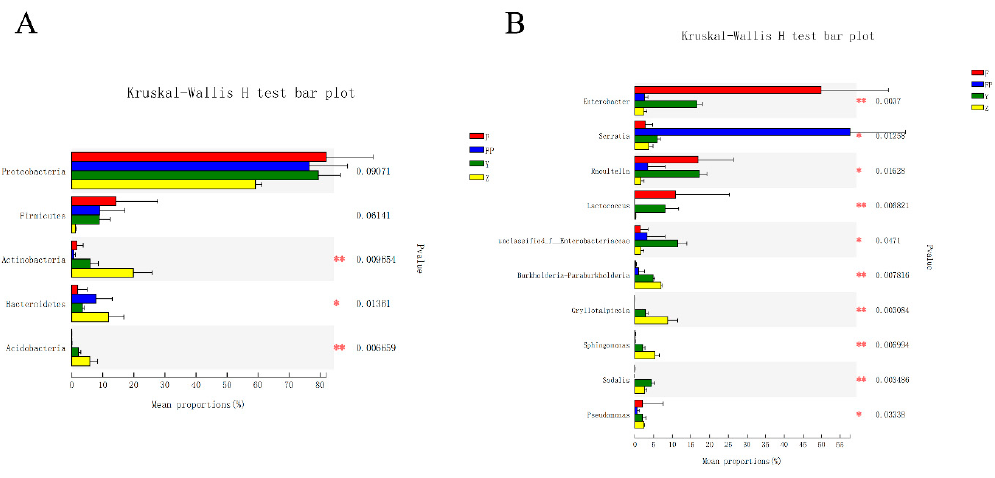
Figure 6. Di ff erences in abundance of microbial phyla and genera in intestine samples of M. alternatus and tissue samples of P. massoniana . Di ff erences in abundance of dominant microbial phyla (( A ); top 5 are shown) and genera (( B ); top 10 are shown) in larval guts, pupal guts, pupal chamber tissues, and larval gallery tissues. (Kruskal-Wallis H test; * p < 0.05, ** p < 0.01, *** p < 0.001).